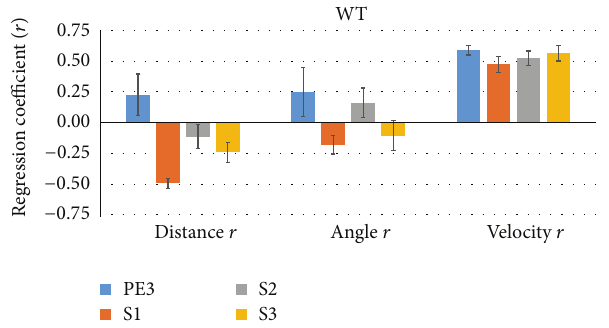
Figure4:ProximityandvelocityarecorrelatedwithS1trialsniffrate in WT mice. On each trial (PE3, S3) for each WT mouse ( 𝑛 = 7 ) the mouse nose proximity (Distance 𝑟 ) and head orientation (Angle 𝑟 ) to the odor source and the velocity of the mice were regressed onto the sniff rate. Distance was negatively correlated during S1 trials, whereas velocity consistently positively correlated with sniff rate.